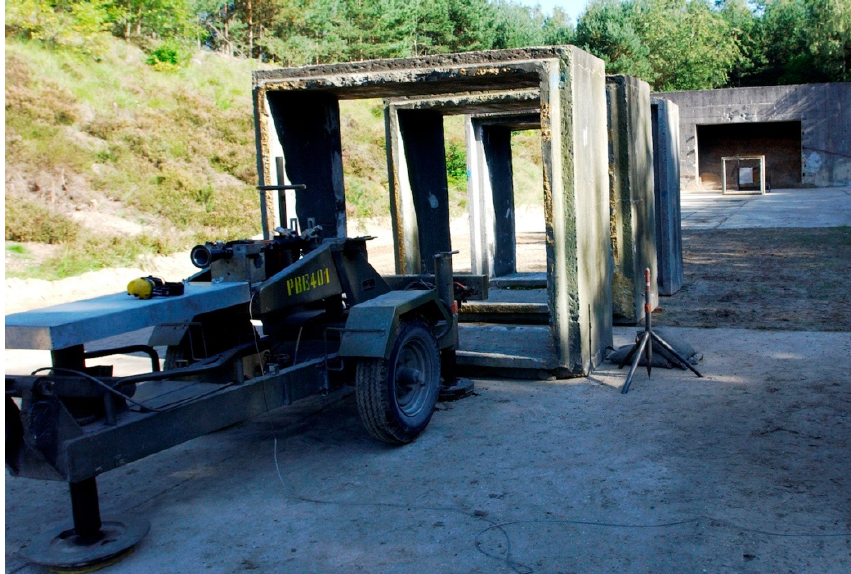
Figure 13. Test setup showing the gun carriage with the launcher and the target area. Table 2. Experimental results for the two considered slat armour prototype systems and a compar- ison with their theoretical efficiencies.